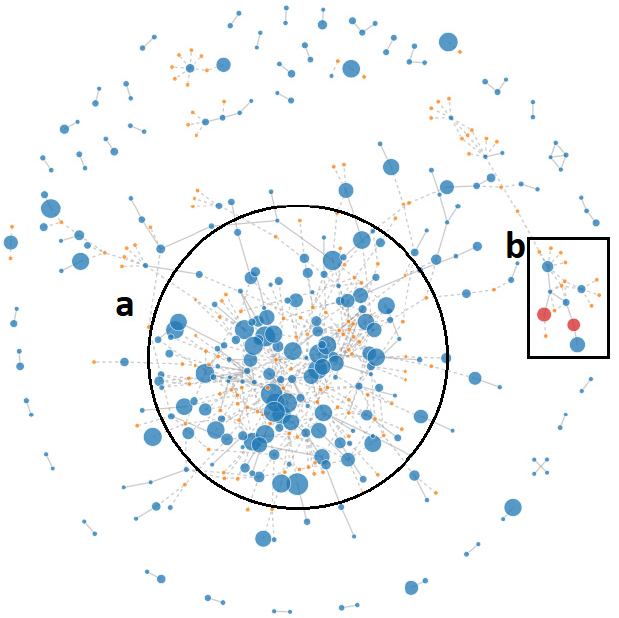
Figure 7. Unpruned, original view of D. congolensis genome in PLACNETw plasmid reconstruction software [19]. ( a ) Chromosome, and ( b ) putative relaxases associated with a pAG1 plasmid encoding TnpB, MyrA, tet (A), and tet (R). This analysis uses sequence paired-end reads. The orange nodes indicate a reference genome or plasmid; the blue nodes indicate a contig, and the difference in their size denotes the difference in length of contigs; the red nodes are contigs containing the Rel (relaxase) protein; dashed lines are scaffold links.